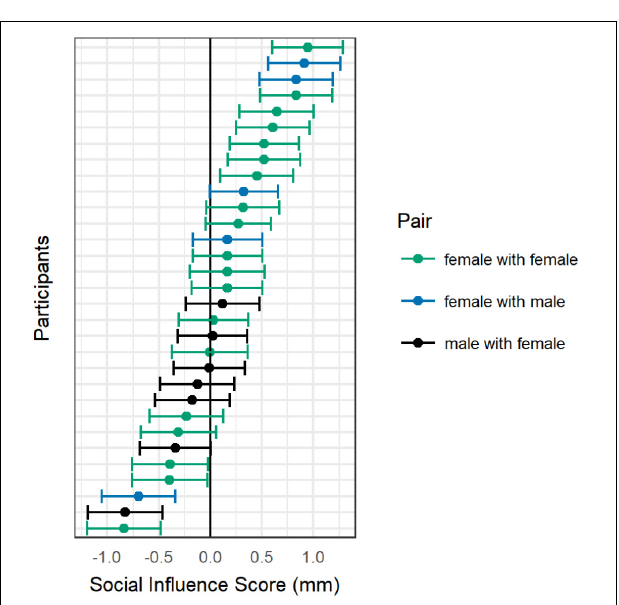
FIGURE 4 | Distribution of attentional shifts across the sample. For each participant, Social Influence Score (SIS) with 95% confidence interval is